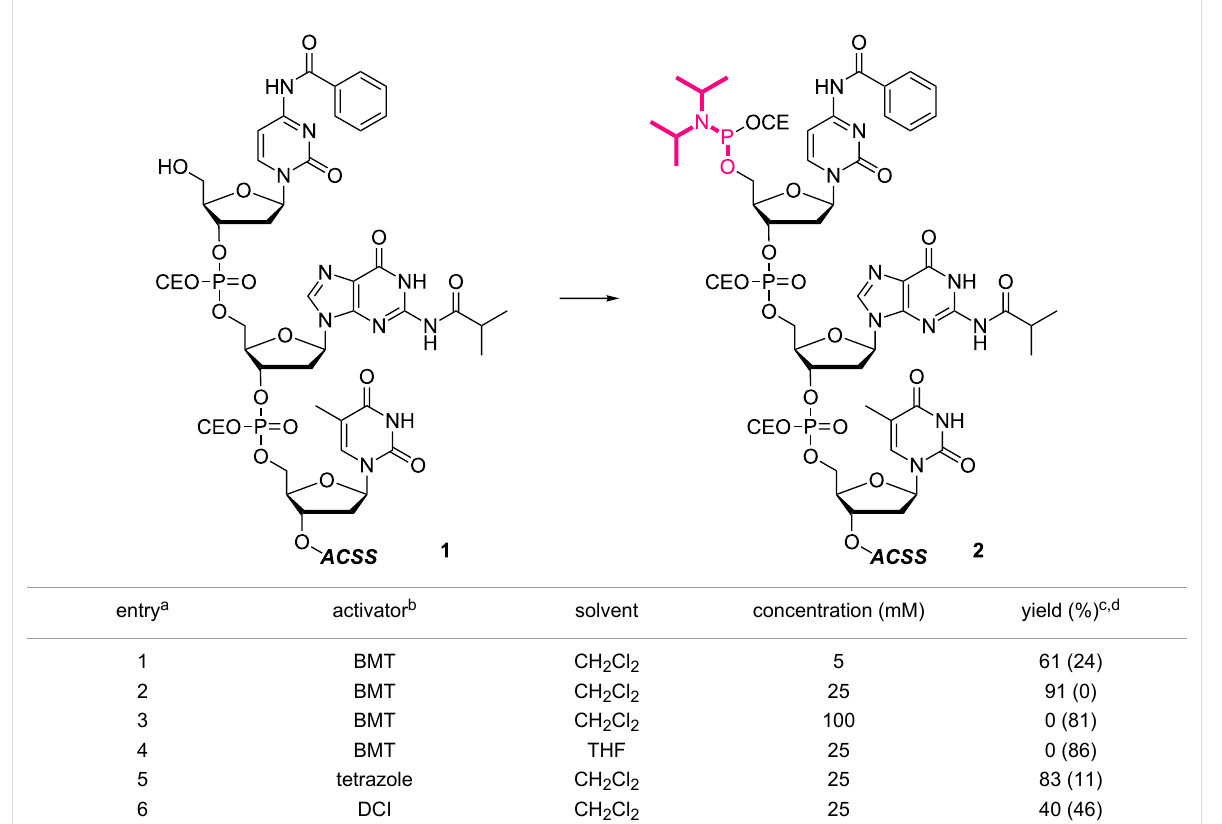
Table 1: Optimization of the conditions for the